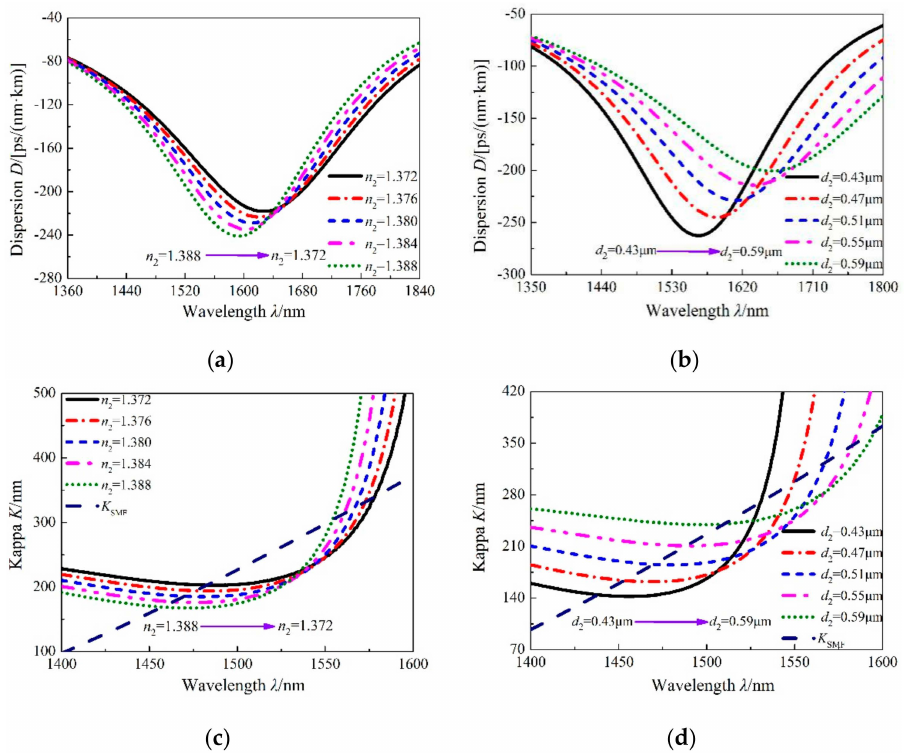
Figure 5. Variation of dispersion ( a ), ( b ) and K value ( c ), ( d ) with n 2 and d 2 , respectively.